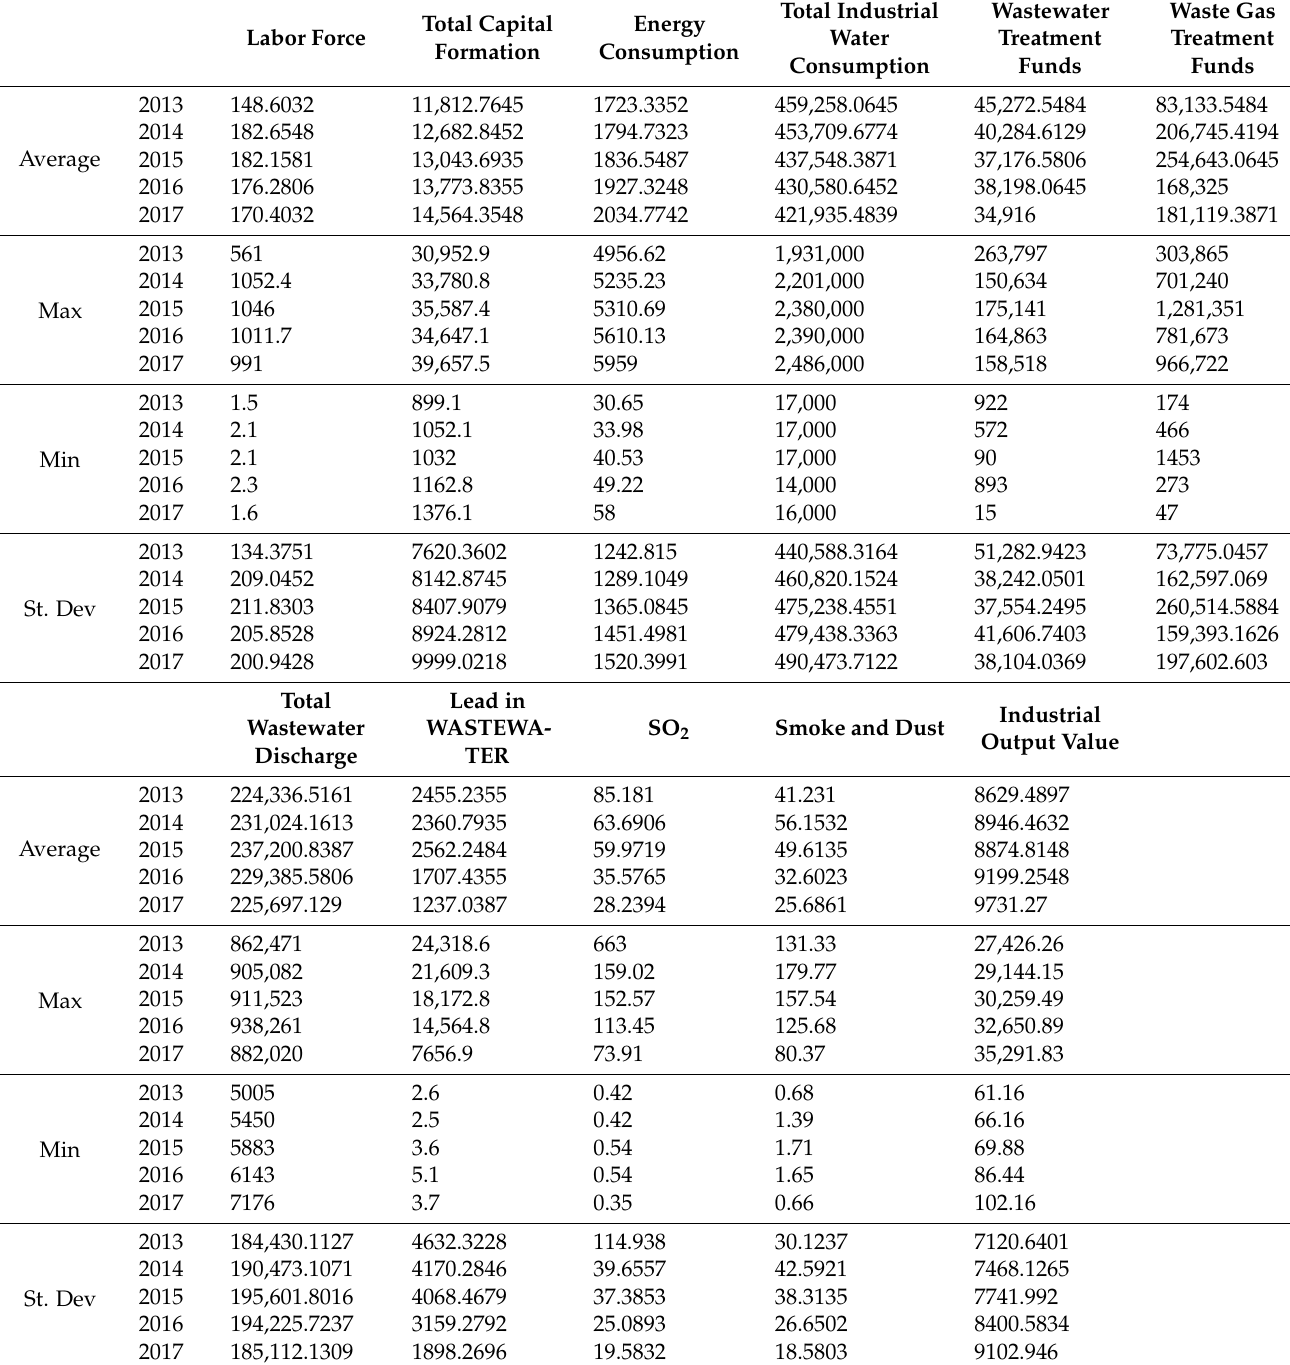
Table 1. Input–output variables from 2013 to 2017 statistical